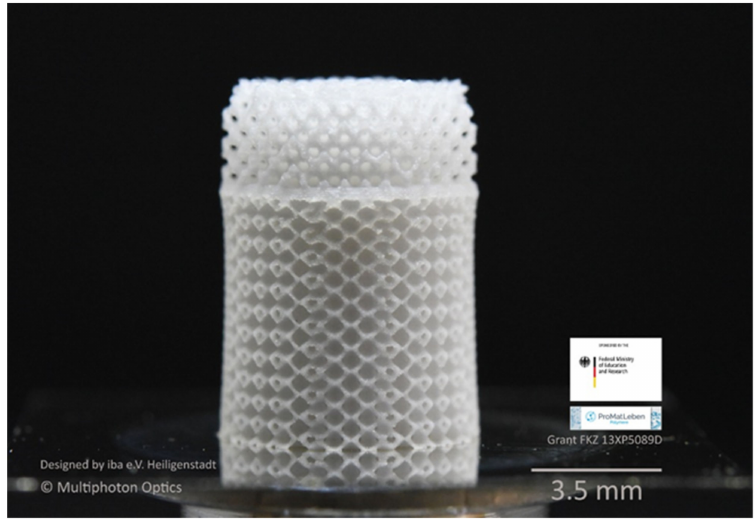
Figure 8. Macroscopic TPA Scaffold made of ORMOCER ® (organically modified ceramic) demon- strating the performance of the TPA process as well as the used TPA machine (LithoProf3D ® -GSII, Multiphoton Optics GmbH) for producing structured 3D bodies, which is transferred to the novel ATZ materials in the next